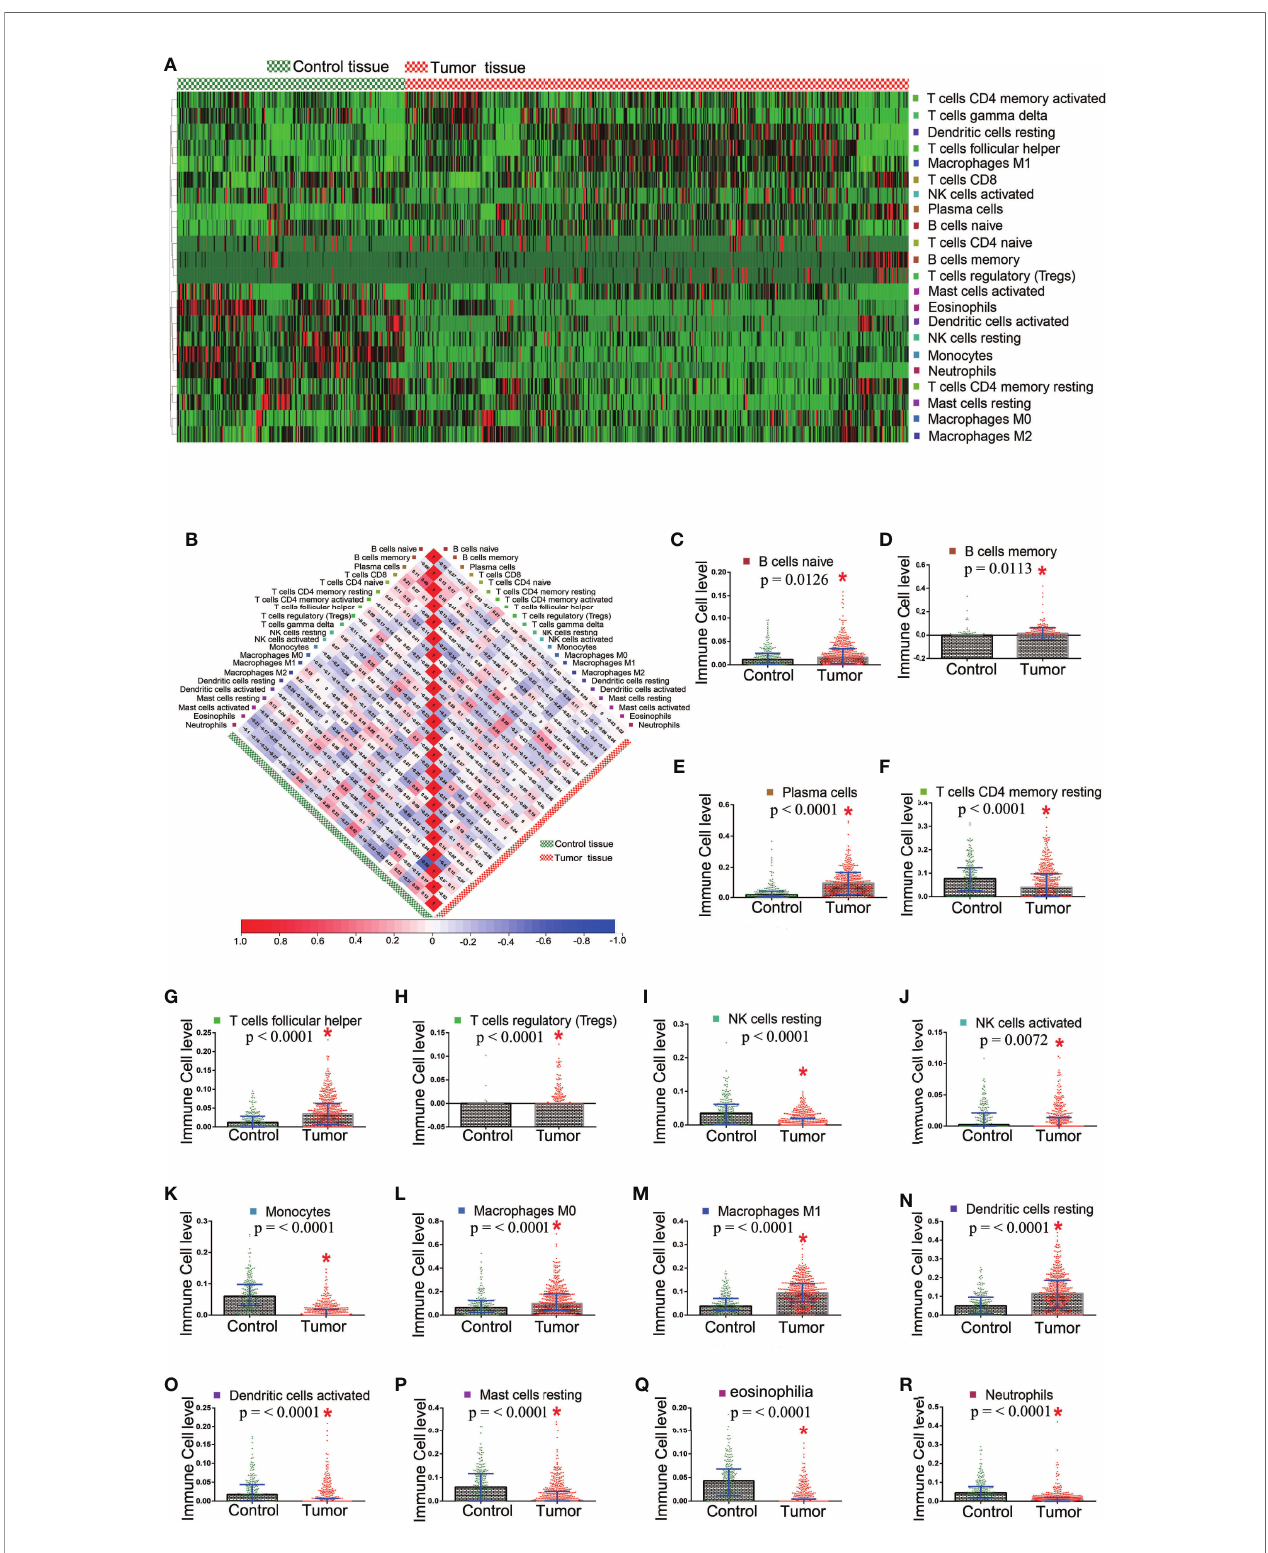
FIGURE 3 | Different distribution of TICs between the tumor and control tissue samples. (A) Heatmap showed the distribution state in tumor and control tissue samples; (B) The correlation among TICs in the tumor and control tissue samples; (C – R) 16 TICs which showed signi fi cant difference in the distribution between the tumor and control tissue